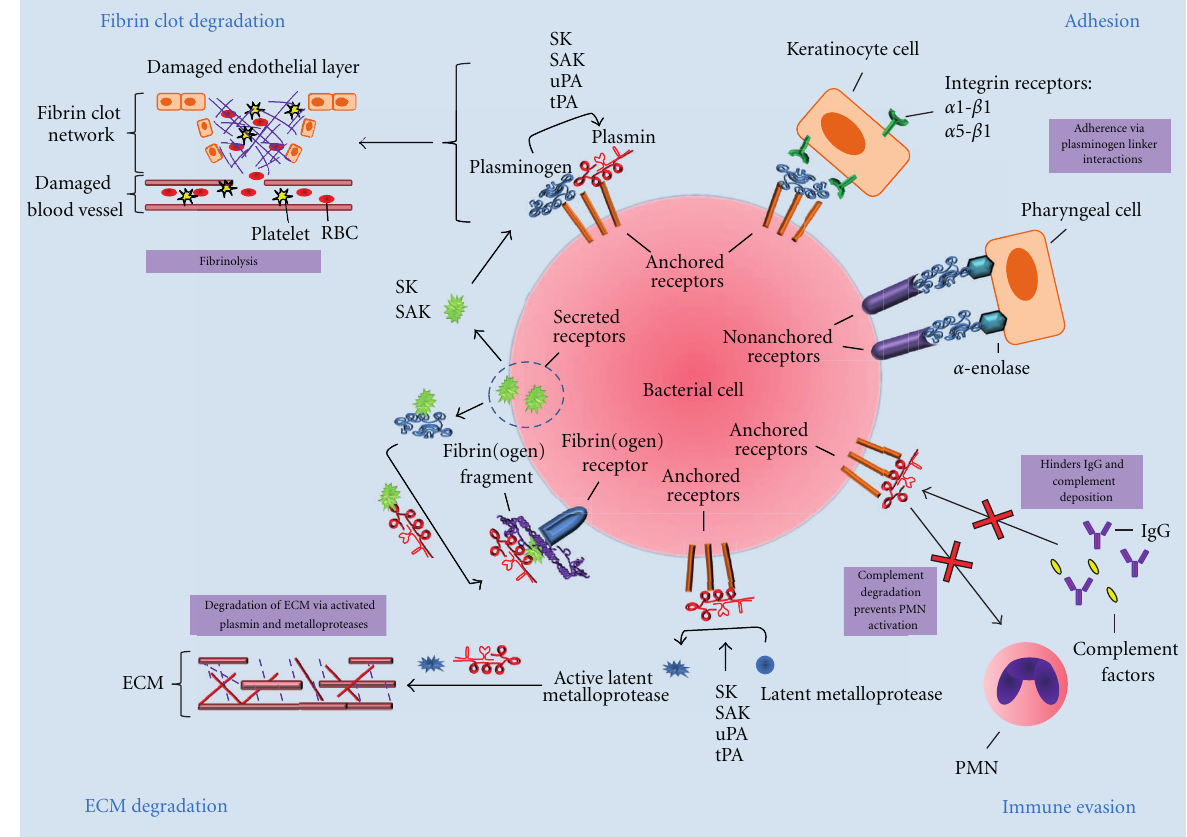
Figure 2: Mechanisms of bacterial cell surface plasmin(ogen) acquisition and its role in bacterial-host interactions. Plasmin(ogen) can be bound directly to the bacterial cell surface via cell-membrane-anchored receptors, nonanchored-cell-surface-associated receptors or indirectly through interactions with fibrinogen and cell surface fibrinogen receptors. Plasmin(ogen) localised on the bacterial cell surface is involved in four main processes; (1) ECM degradation via activated metalloproteases and plasmin; (2) fibrinolysis via plasmin; (3) immune evasion through plasmin-mediated degradation of immune e ff ectors, including complement components and immunoglobulins; (4) adherence to host cells via plasminogen-linker interactions with host cell surface receptors. ECM: extracellular matrix; IgG: immunoglobulin G; RBC: red blood cell; SAK: staphylokinase; SEN: streptococcal α -enolase; Ska: streptokinase; tPA: tissue plasminogen activator; uPA; urokinase plasminogen